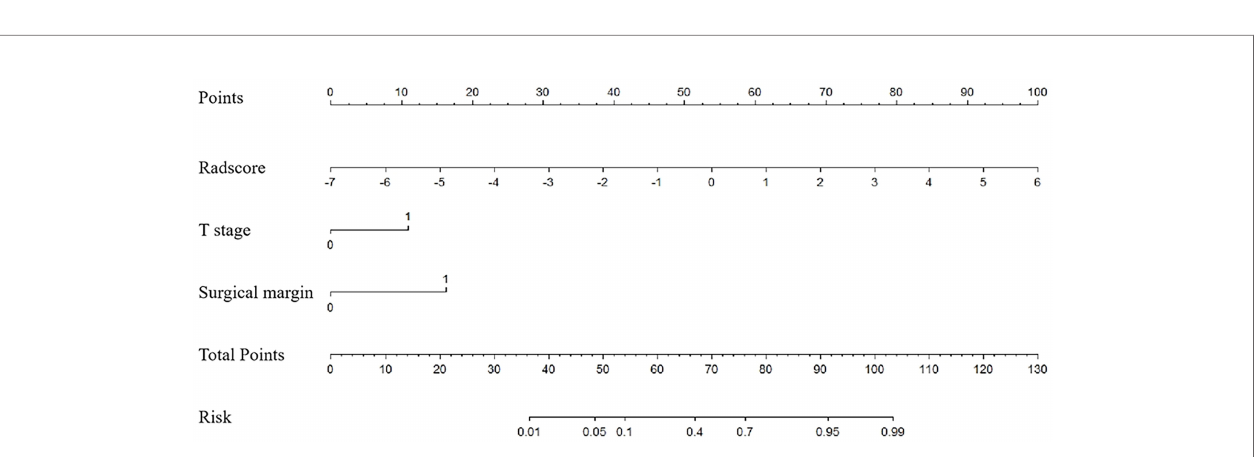
FIGURE 3 | Nomogram for risk prediction of ER with the radiomics signature (Radscore) and clinical factors (T stage and surgical margin)